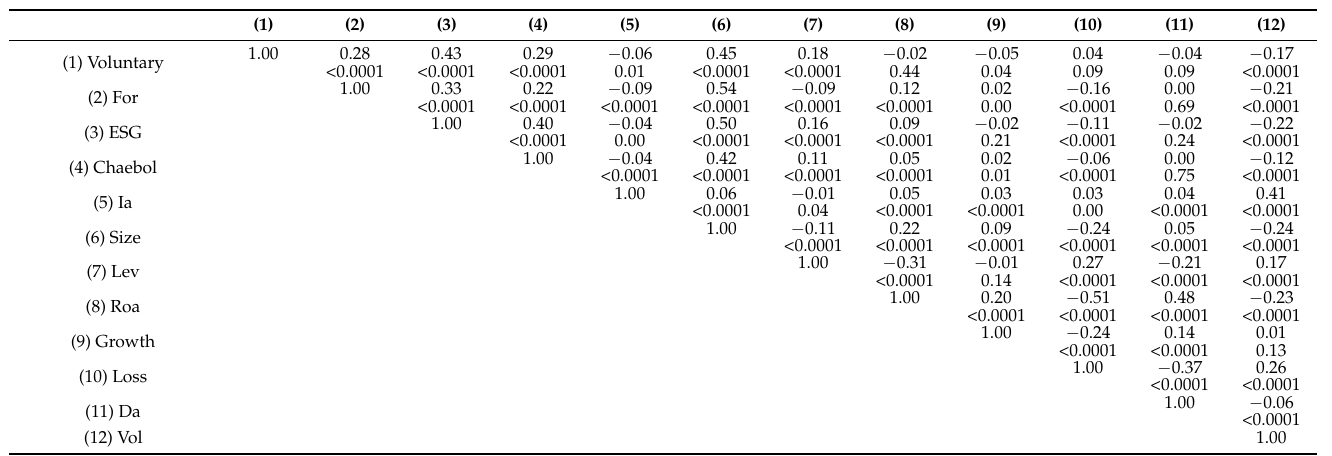
Table 4. Pearson correlation.